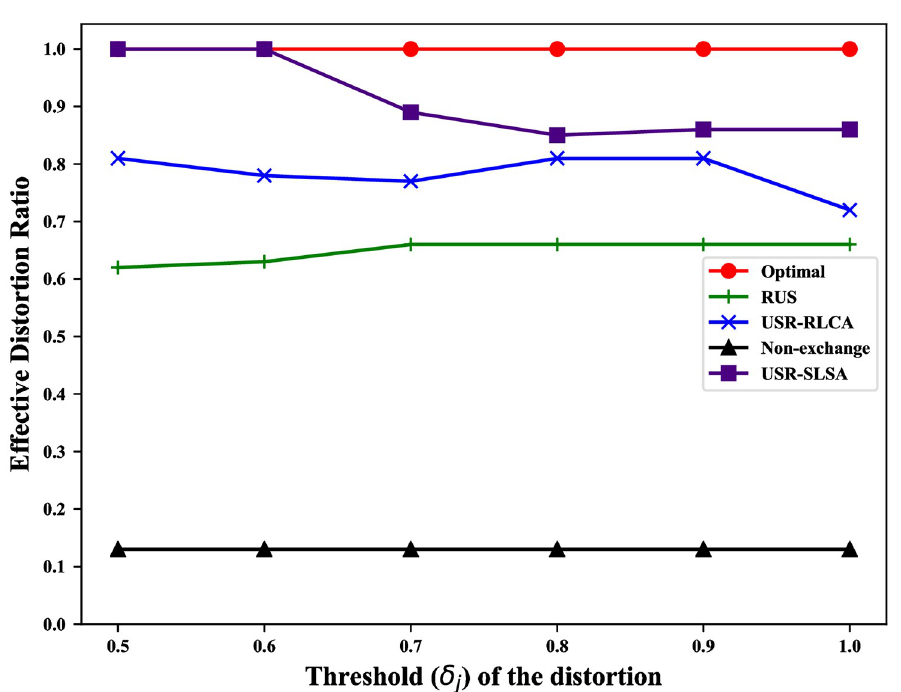
Fig 6. Impact of δ j on the privacy-preserving efficiency.